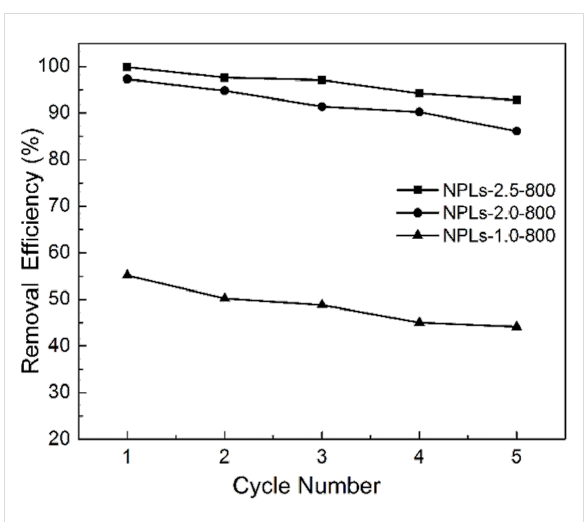
see that the as-prepared NPLs-2.5-800 sample in our study displays relatively good adsorption performance for RhB dye.